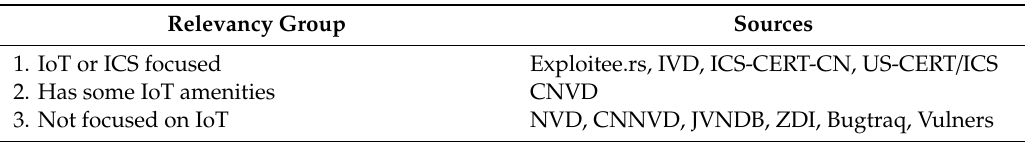
Table 10. Data sources grouped by their relevancy for